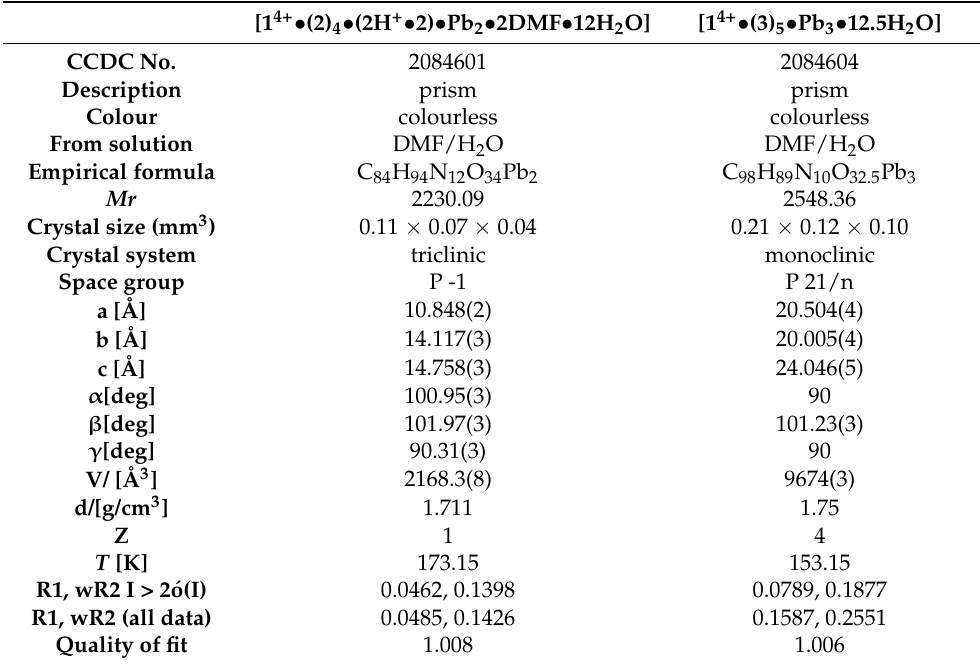
One molecule of 2 threads through an individual 1 4+ via C-H . . . π interactions between the bridge bezene planes on 1 4+ and the aromatic ring of 2 highlighted in magenta in Figure 3a. The interpenetrated structure is further stabilized via intermolecular hydrogen bonding interactions (e.g., C(10A)-H(10A) . . . O(1) and C(10)-H(10B) . . . O(1B)) between